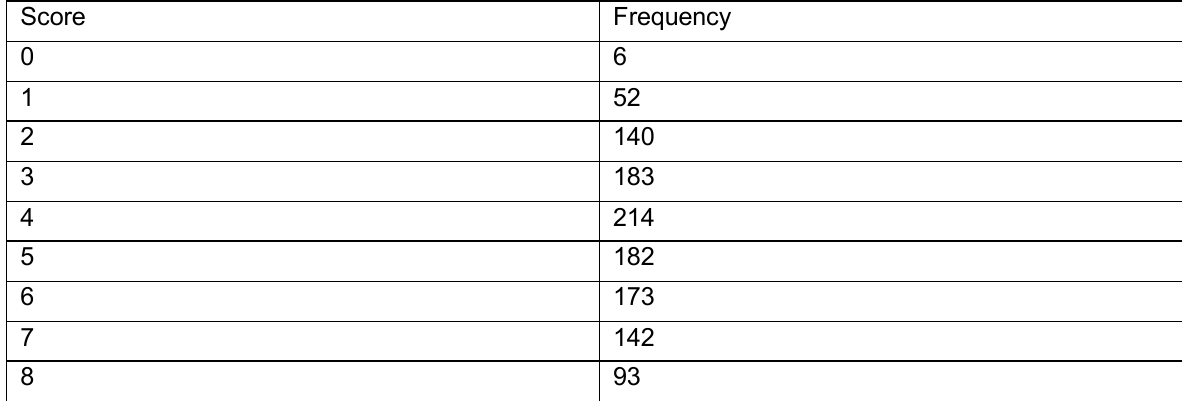
Table 2: Frequency Distribution of The Financial Behavior